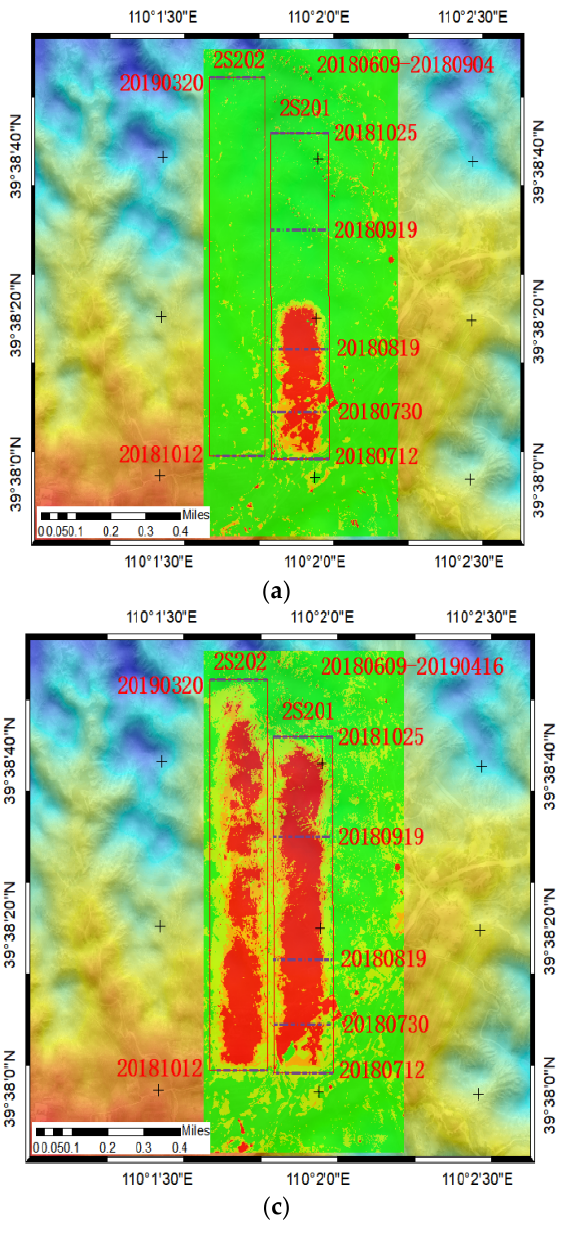
Figure 11. ( a – c ) are respectively the accumulated settlement maps of UAV time series; 2S201 and 2S202 are working faces; the data is of production.